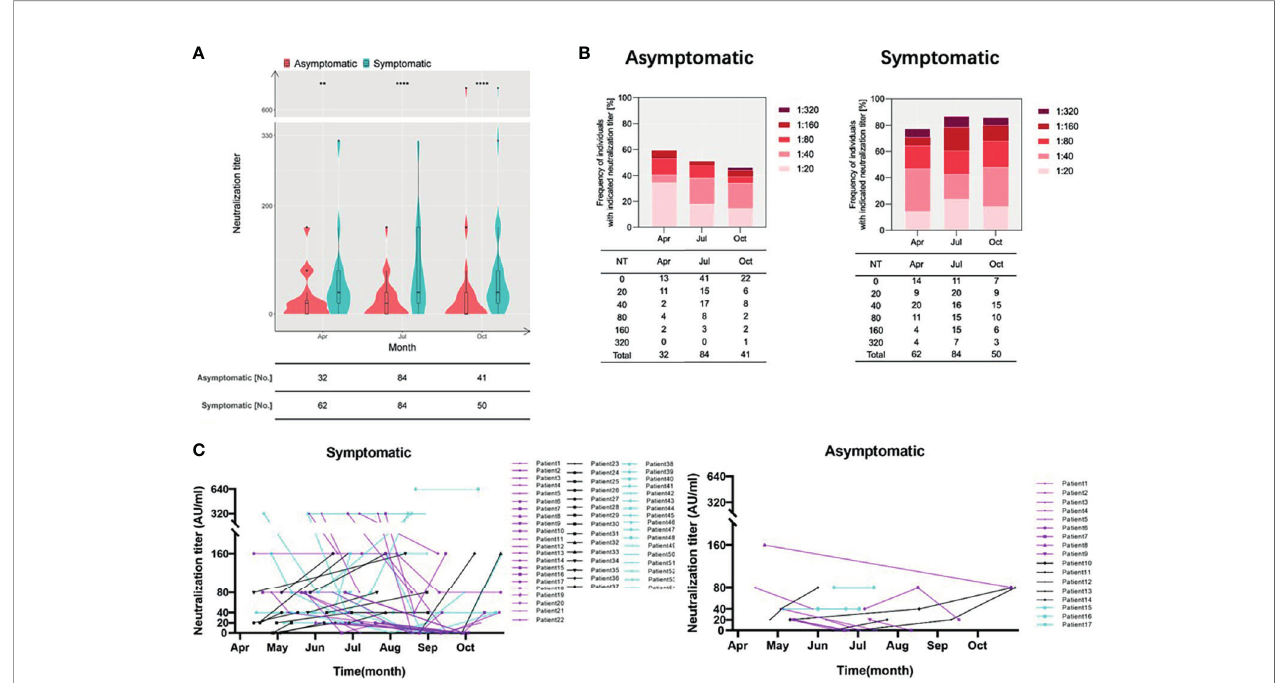
FIGURE 4 | Neutralization activity is de fi ned by the occurrence of symptoms. (A) Violin plots show the distribution of neutralization titers of sera derived from derived from asymptomatic individuals (red) and symptomatic patients (blue) during April and October 2020. Boxes depict medians (middle line), 75% quartiles (upper bound), and 25% quartiles (lower bound). Whiskers indicate 1.5-times interquartile ranges above and below boxes. The table below the fi gure highlights the number of clinical specimens that have been assessed. Statistical analysis was performed by two-tailed Mann-Whitney U test. Asterisks depict levels of signi fi cance as follows: **p < 0.01; ****p < 0.0001. (B) Like in (A) but the frequencies of individuals exhibiting indicated neutralizations titers are depicted. (C) Sequential sampling and analyses of neutralization activity in 17 asymptomatic individuals and 54 symptomatic COVID-19 patients. Different colours highlight different trends as follows: purple: declining trend; black: increasing trend; light blue: unchanged